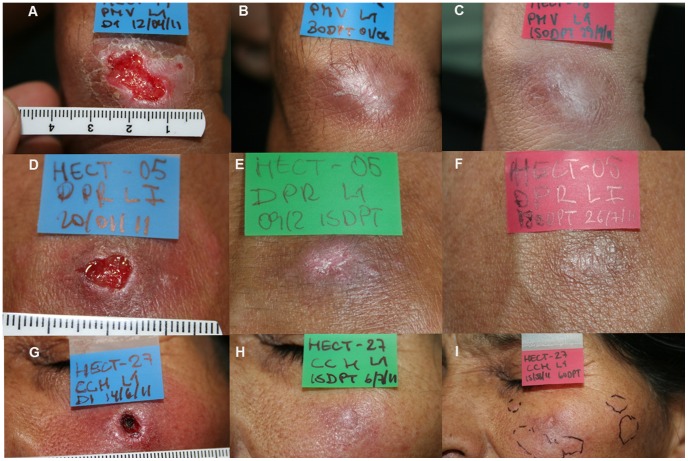
Response to HECT-CL therapy.a) Patient 19 (PT) at baseline; b) Patient 19 thirty days after HECT-CL with M4 clinical status; c) Patient 19 six months after HECT-CL with complete re-epithelialization; d)Patient 5 (PT) at baseline; e) Patient 5 fifteen days after HECT-CL with M4 clinical status; f) Patient 5 cured six months after HECT-CL; g) Patient 27 (NT) at baseline; h) Patient 27 fifteen days after HECT-CL with M4 status; i) Patient 27 two months after HECT-CL with complete re-epithelialization of lesion but 2 subcutaneous tracts.